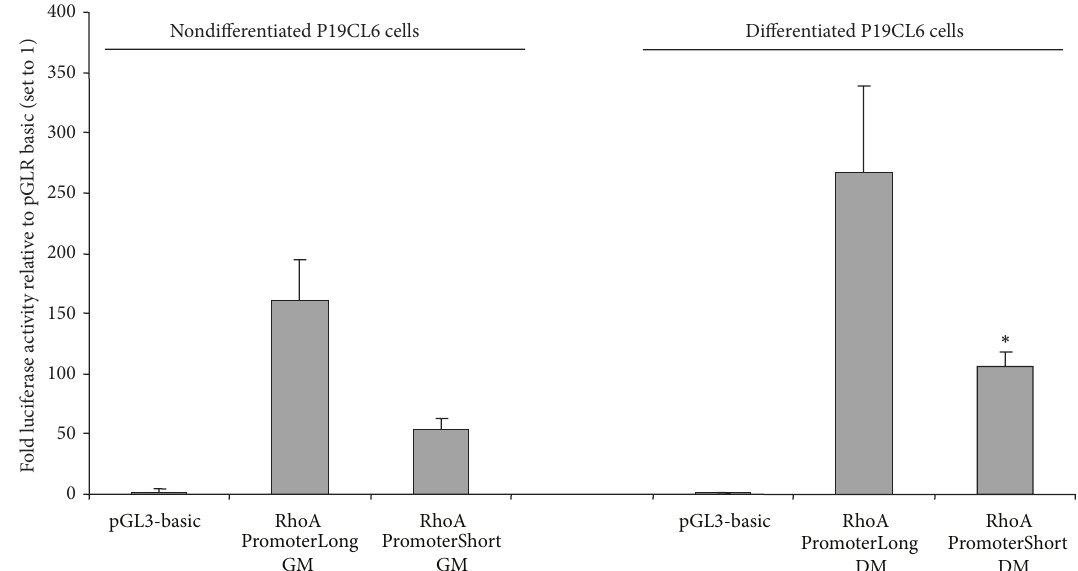
Figure 3: Relative promoter activity of PromoterLong and PromoterShort in nondifferentiated and cardiomyocyte-differentiated P19CL6 cells. Constructs containing different lengths of the putative promoter region of mouse RhoA (PromoterLong and PromoterShort) were cloned upstream of the firefly luciferase coding sequence in pGL3-Basic and cotransfected with the pRL-TK coreporter vector (expresses Renilla luciferase) into nondifferentiated and differentiated P19CL6 cells 11 days after DMSO induction. The firefly luciferase activity of each sample (expressed as relative light units) was normalised to the Renilla luciferase activity and expressed as this ratio (fold luciferase activity). The data represents the mean ± SEM of six individual transfections for each construct. ∗ 𝑃 < 0.05 compared to activity in nondifferentiated cells (Student’s 𝑡